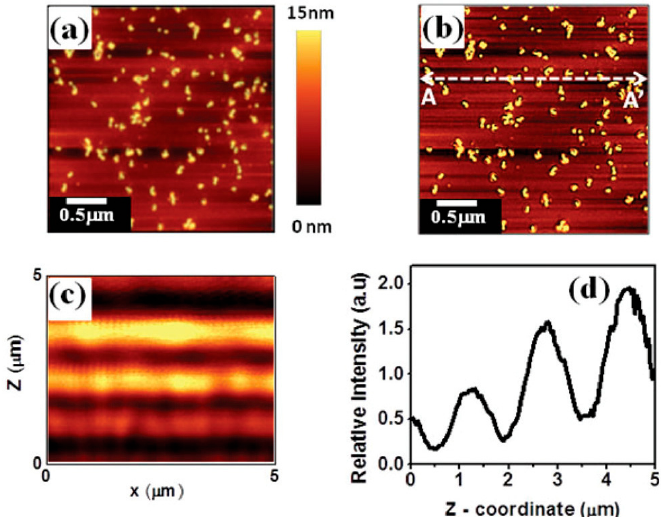
Figure 7. ( a ) Topographic AFM and ( b ) c-SNOM images obtained simultaneously; ( c ) Light intensity mapping ( x , z ) measured along the A–A’ cross-section in panel ( b , d ) the integrated intensity profile in the z -direction along the A–A’ cross-section showing the positions of constructive (maxima) and destructive (minima) interference of forward light scattered from Cu-nanoparticles in panel ( c ). Reproduced with permission from [48], Copyright Nanoscale, 2015.